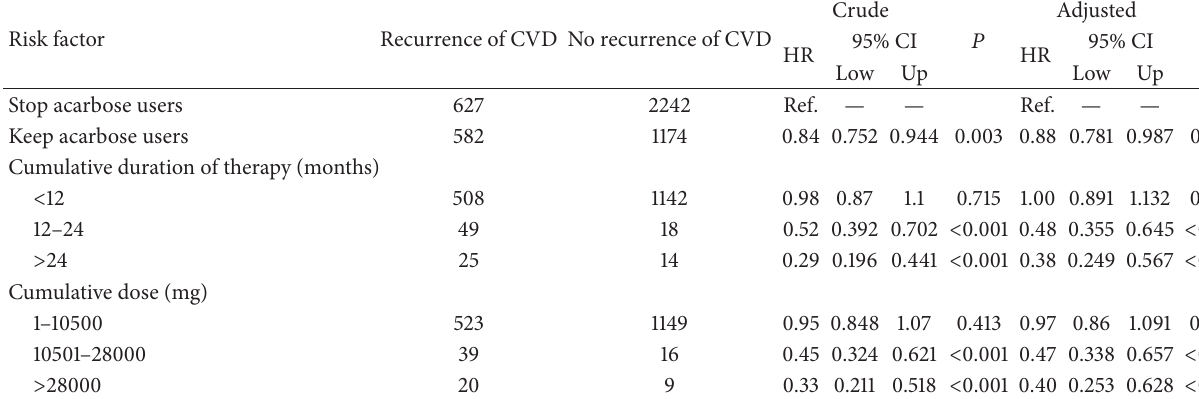
Table 3: HR of recurrent CVD by keep or stop using